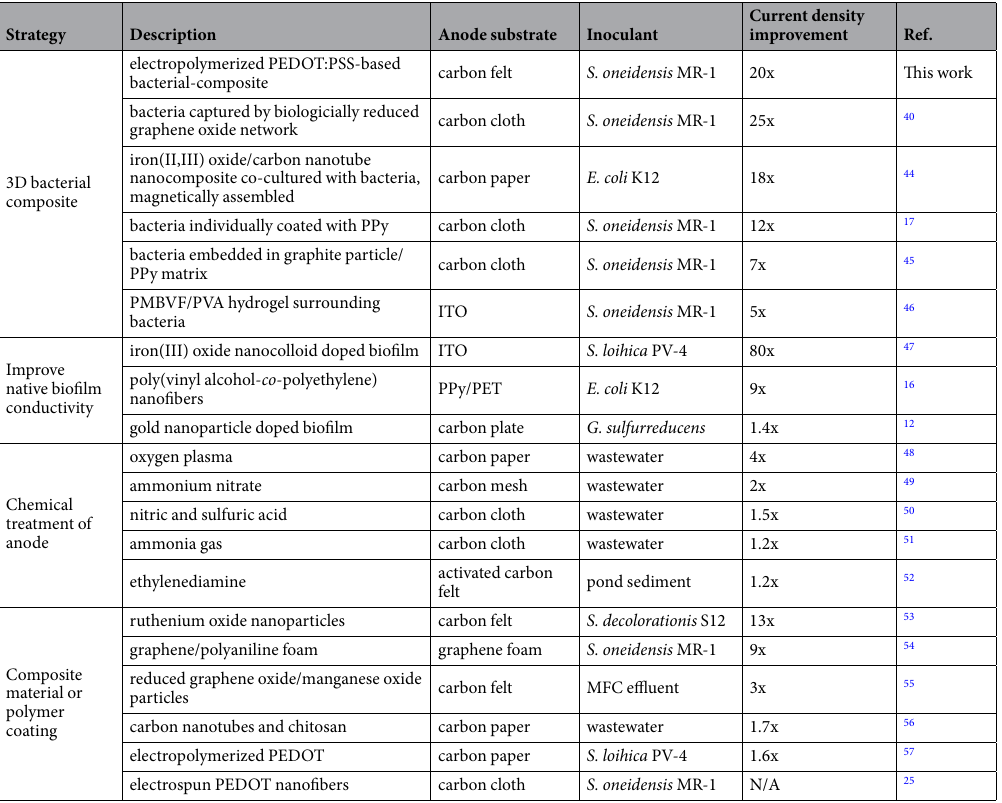
Table 1. Comparison of MES anode modifications and current density